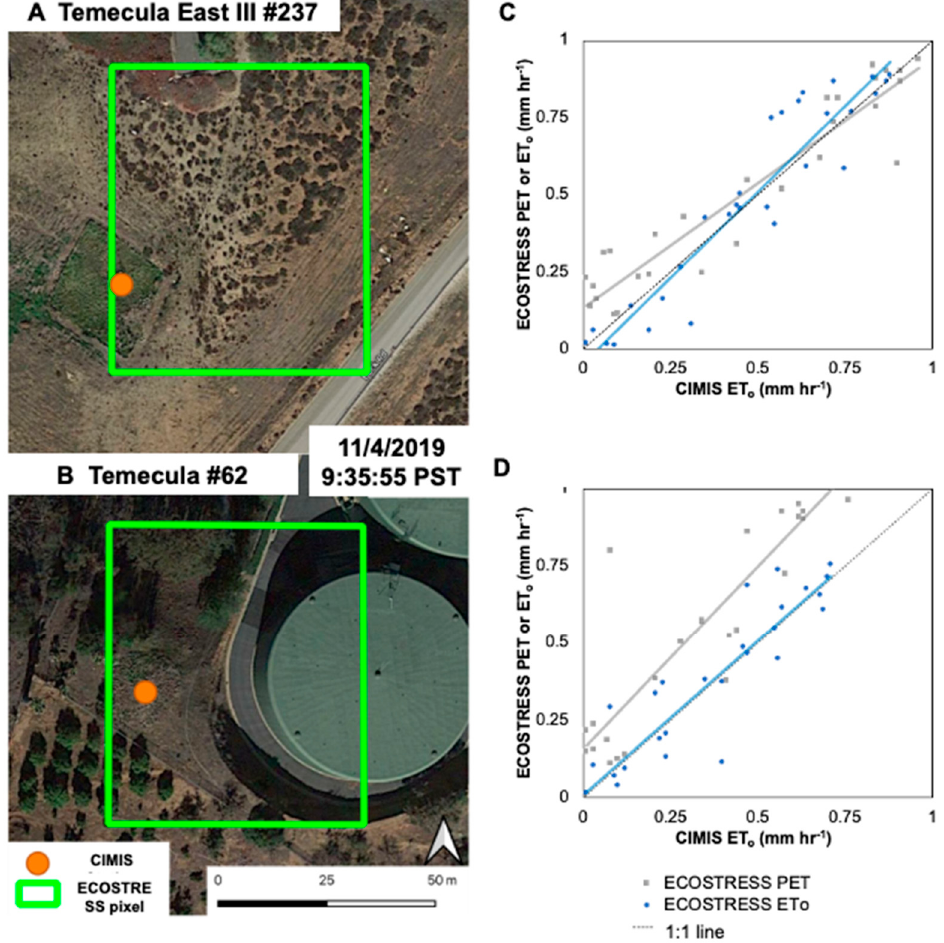
Figure 3. CIMIS sites ( A , B ) exhibit varying levels of spatial heterogeneity, with examples shown here. Station 237, while showing paved areas, is largely vegetation and some bare dirt, whereas Station 62 is within 50 m of a water tower. ( C , D ) exemplify the ECOsystem Spaceborne Thermal Radiometer Experiment on Space Station (ECOSTRESS) potential evapotranspiration (PET) (pre-calibrated; gray squares) and ET o (calibrated; blue circles) correlated to CIMIS reference evapotranspiration ( ET o ). Stations 237 and 62 correspond with Figure 2A,B and Figure 2B,D respectively.